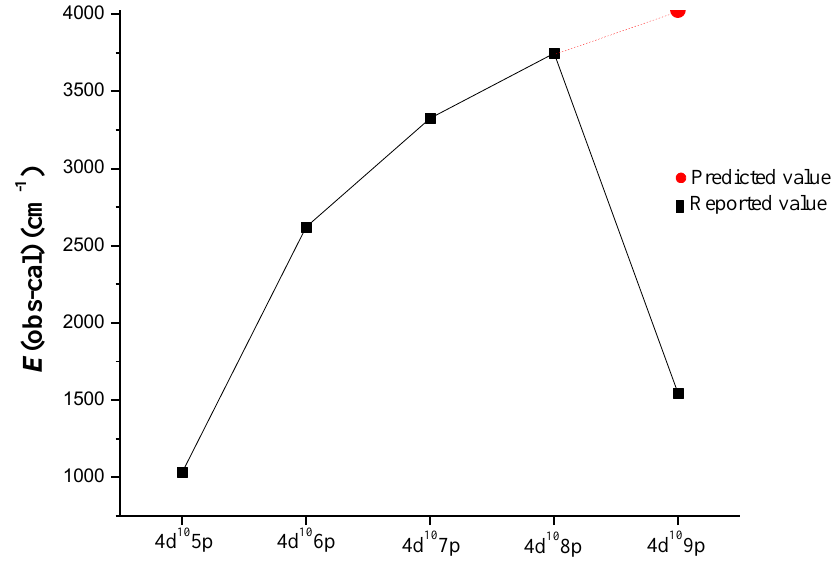
Figure 2. A plot of the observed and calculated energy difference in 4d 10 n p series of In III.